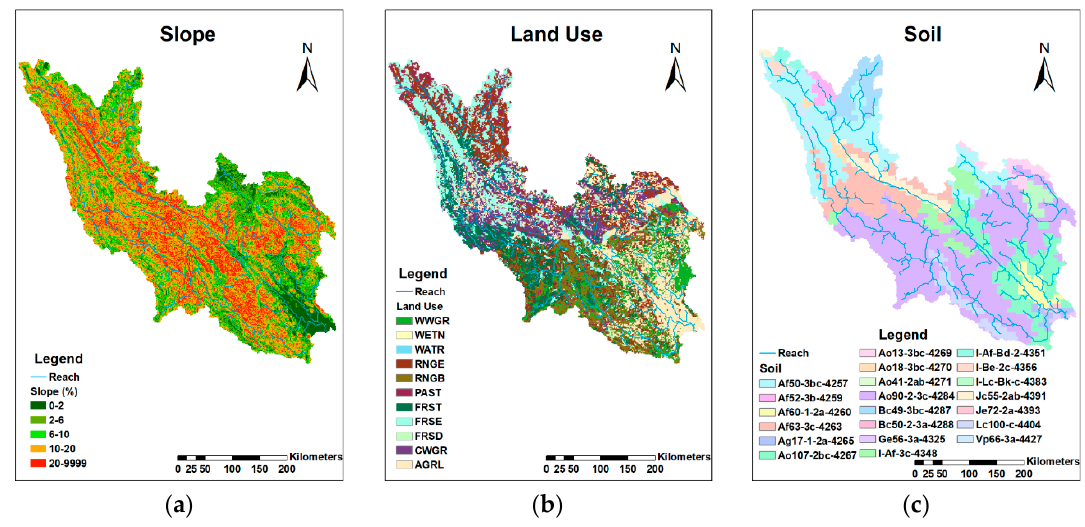
Figure 2. ( a ) Slop classes; ( b ) land use map; ( c ) soil types.